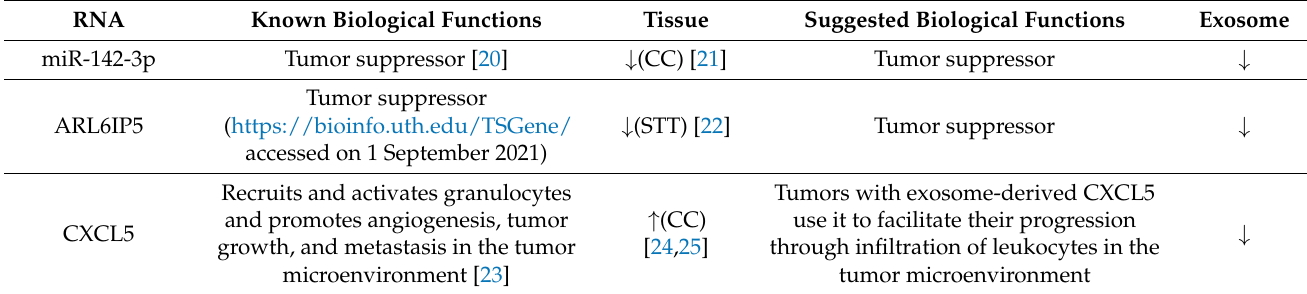
Table 2. Suggested biological functions of selected plasma exosomal RNAs.